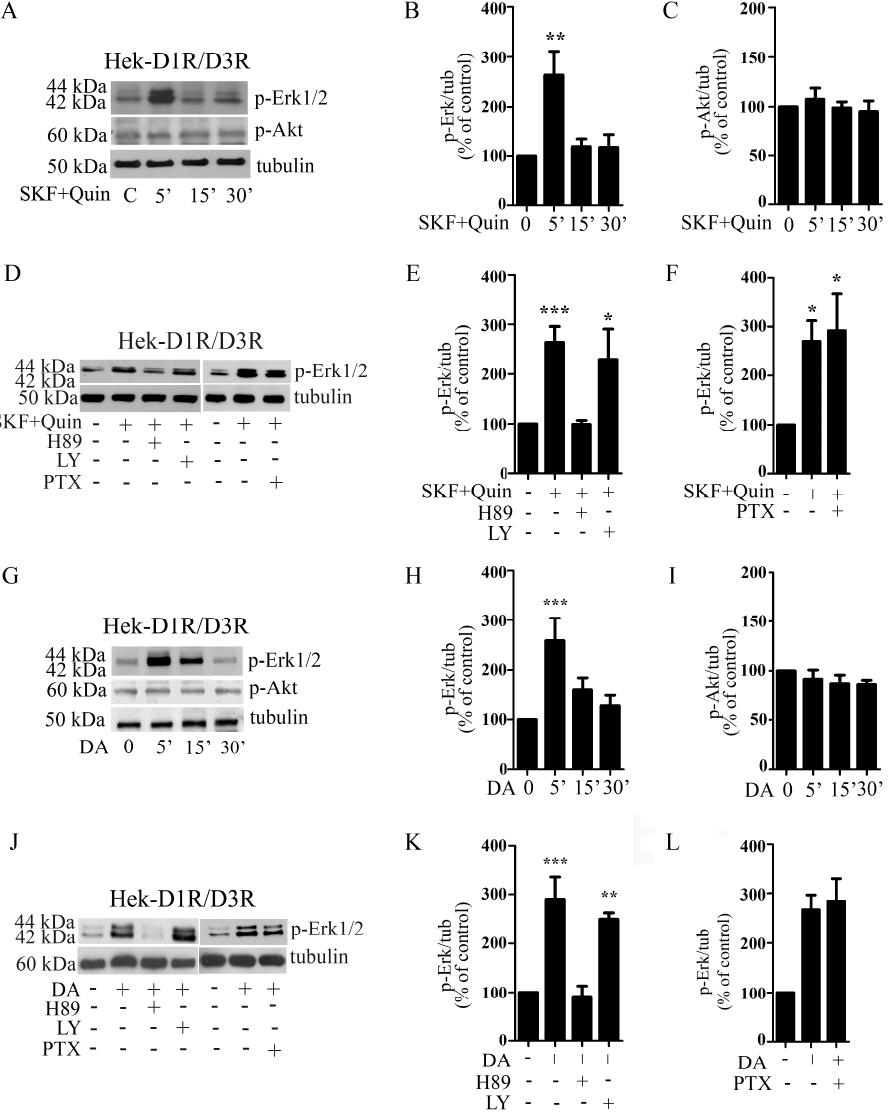
Figure 2. In Hek-D1R/D3R cells, D1R and D3R co-stimulation promotes the activation of the PKA- Erk1/2 pathway. (A) Hek293 cells transiently expressing both the D1R and the D3R (Hek-D1R/D3R) were exposed to both SKF81297 (SKF; 1 μ M) and quinpirole (Quin; 1 μ M) for 5–30 min (min) and analyzed for Erk1/2 and Akt phosphorylation (p-Erk1/2 and p-Akt, respectively) using Western Blot (WB); a representative WB is shown; ( B , C ) densitometric analysis of blots (n = 4) with specific p- Erk1/2 (panel B ) and p-Akt (panel C ) levels normalized to the corresponding tubulin levels. Bars represent the mean ± S.E.M. *** p < 0.001 vs. untreated cells. ( D ) Hek-D1R/D3R cells were exposed to both SKF (1 μ M) and Quin (1 μ M) for 5 min in the presence or in the absence of H89 (1 μ M) or LY294002 (LY, 10 μ M) added 30 min before agonists challenging. PTX (100 ng/mL) was adminis- tered overnight before agonists treatment. Cells were analyzed for p-Erk1/2; representative WB are shown; ( E , F ) densitometric analysis of blots with specific p-Erk 1/2 levels normalized to the corre- sponding tubulin levels. Bars represent the mean ± S.E.M. *** p < 0.001 vs. untreated cells; (n = 4) ( G ) Hek-D1R/D3R cells were exposed to DA (1 μ M) for 5–30 min and analyzed for p-Erk1/2 and p-Akt using WB; a representative WB is shown; ( H , I ) densitometric analysis of blots (n = 4) with specific p-Erk1/2 (panel H ) and p-Akt (panel I ) levels normalized to the corresponding tubulin levels. Bars represent the mean ± S.E.M. *** p < 0.001 vs untreated cells. ( J ) Hek-D1R/D3R cells were exposed to either H89 (1 μ M) or LY294002 (LY, 10 μ M) for 30 min and challenged with DA (1 μ M) for 5 min. In another set of experiments, cells were treated overnight with PTX (100 ng/mL), followed by expo- sure to DA (1 μ M) for 5 min, and analyzed for p-Erk1/2; representative WB are shown; ( K , L ) densi-